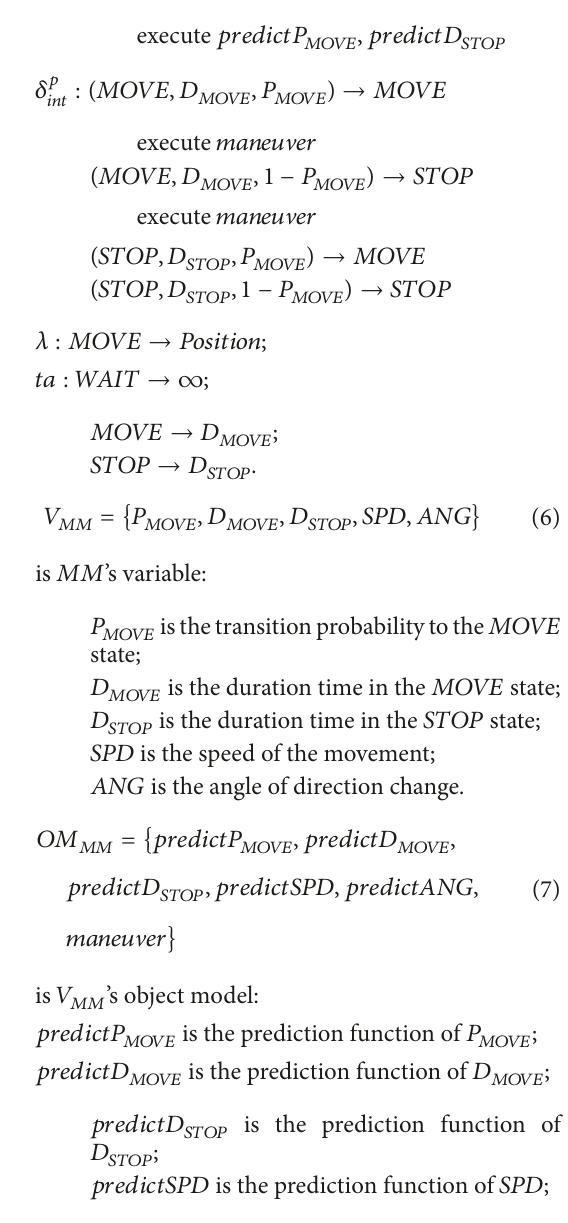
the 𝑇 𝑆𝑇𝐴𝑅𝑇 time and then waits in the 𝑊𝐴𝐼𝑇 state.